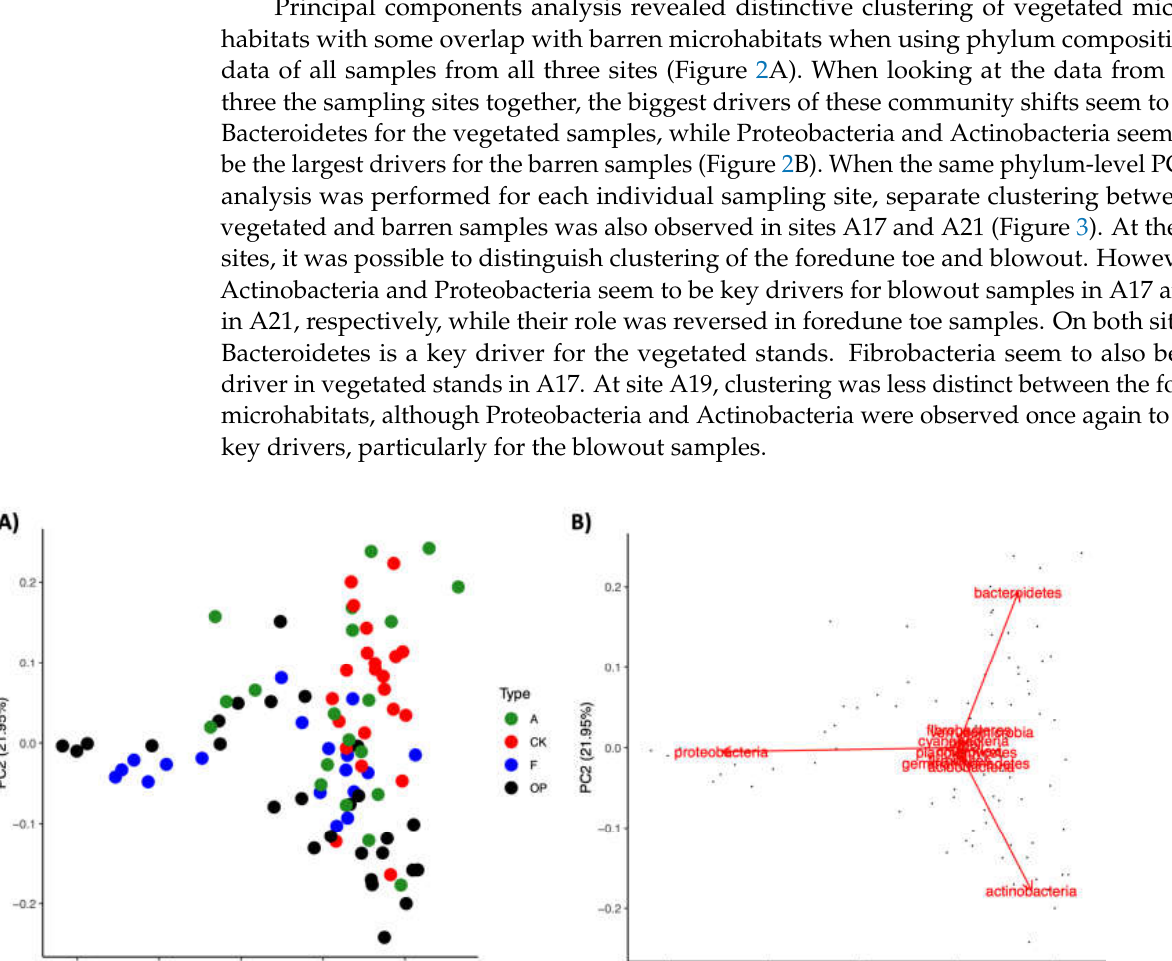
Figure 3. Principal components analysis of the four dune microhabitat (blowout (OP), A. breviligulata ( A ), C. kobomugi (CK), and foredune toe ( F )) microbiomes based on percentage community composition at the phylum level. Analysis was per- formed separately for sites A17 ( A ), A19 ( B ), and A21 ( C ), with arrows representing the vectors of factor loadings of key genera ( D – F , respectively). The percent variation explained by the PCs of each principal components analysis is indicated on the axes. 3.3. Genus-Level Variability in Microbiome Composition Differences in genus composition are presented in Table 2. Of the 58 genera that rep- resented more than 0.1% of the community composition, 14 were found to have significant differences between microhabitat categories. The genera Devosia (F 2,85 = 35.88, p < 0.0001),